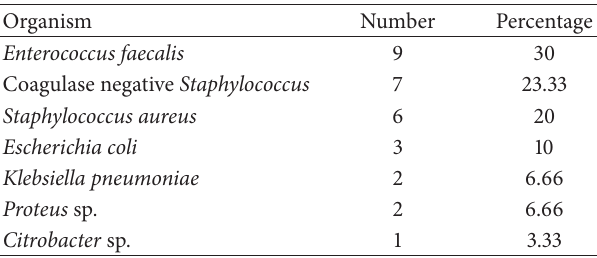
Samples were collected in sterile containers by masturbation after a minimum abstinence period of 3 days. None of the patients had taken prior antibiotics.